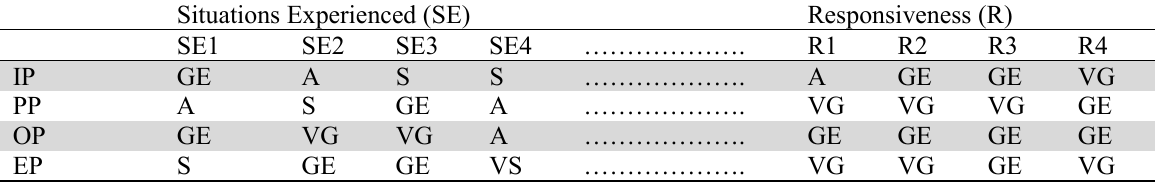
Showing linguistic response from manager 1 Situations Experienced